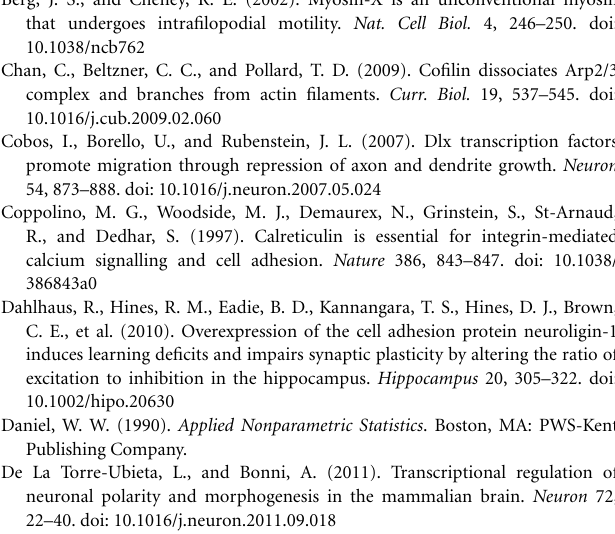
Figure S1 | Simiate influences Actin dynamics. (A–D) Representative images illustrating fluorescence recovery after photobleaching (FRAP) in filopodia from Lifeact-RFP/GFP (“control”; A,C ) and LifeactABD/ GFP-Simiate (“Simiate”) transfected HEK-293 cells. (A,C) Control. (B,D) Simiate. Shown are the second slowest (A,B) and the second fastest (C,D) recovery observed ( n = 22 per group), whereat gray dots indicate bleaching (at 3s). (E) Quantification of the fluorescence recovery half-times after photobleaching in filopodia from GFP (“control”) and GFP-Simiate expressing HEK-293